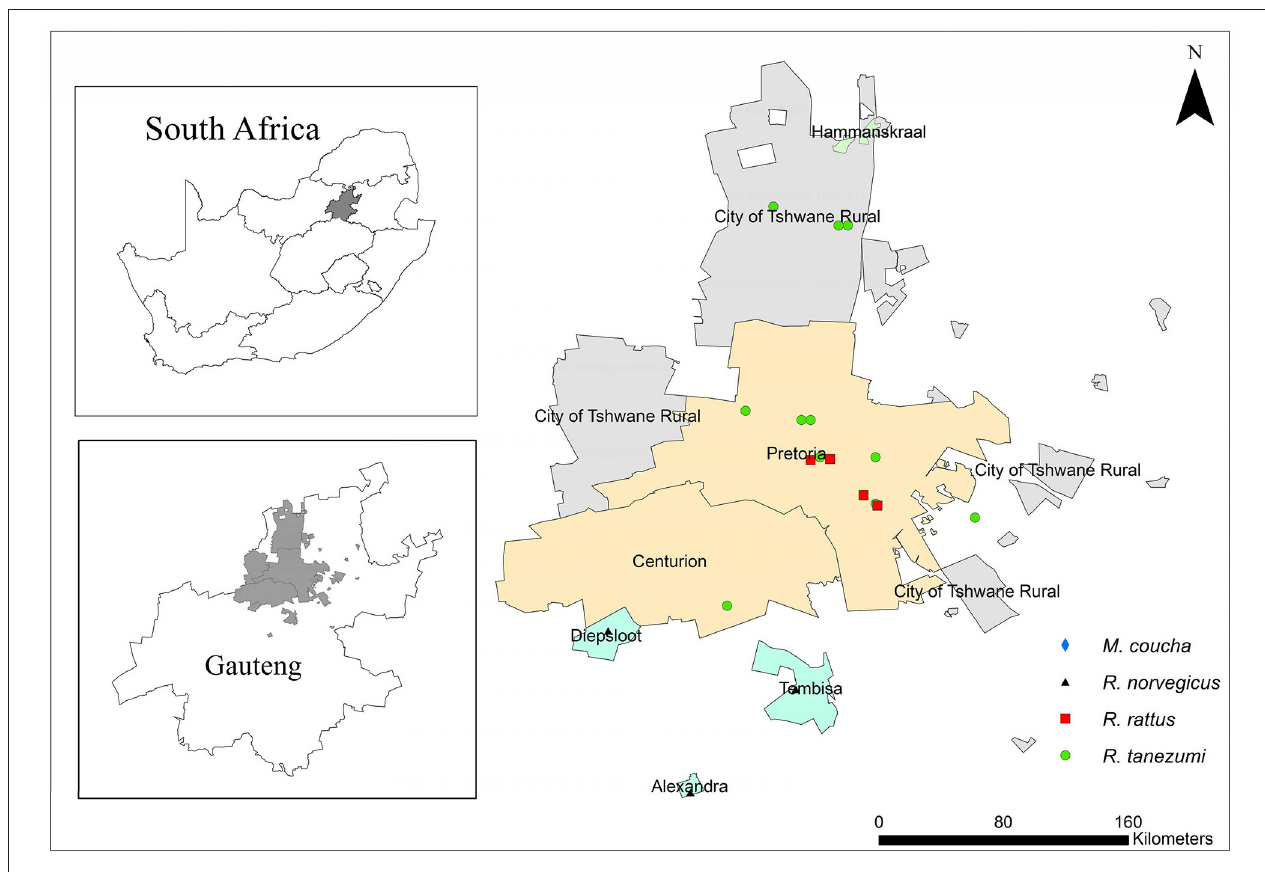
FIGURE 1 | A map of Gauteng Province, South Africa showing sampling localities of commensal, indigenous Mastomys coucha and commensal, invasive Rattus norvegicus , Rattus rattus , and Rattus tanezumi